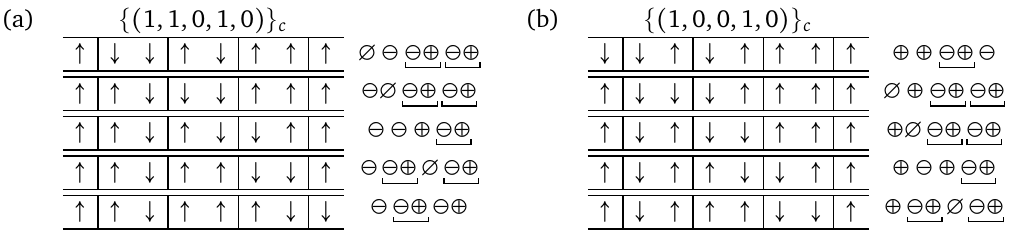
Figure 1: States forming a basis for the configurations {( 1, 1, 0, 1, 0 )} c (a) and {( 1, 0, 0, 1, 0 )} = 8. The representation in terms of elementary parti- c (b) with L cles is displayed close to the state. Note that the two invariant spaces are mapped into one another under a shift by one site (the effect of this shift is the replacement b j → 1 − b j